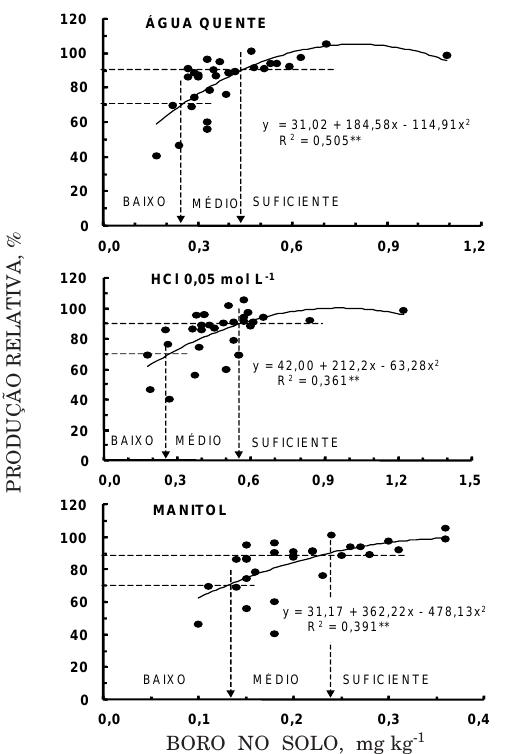
Figura 1. Produção relativa de matéria seca (PR) do girassol em dois cultivos sucessivos em função do boro extraído do solo pela água quente, HCl 0,05 mol L -1 e manitol 0,05 mol L -1 + CaCl 0,01 mol L -1 , e faixas de teores de boro 2 no solo, considerando PR de 90 e 70% nas equações de